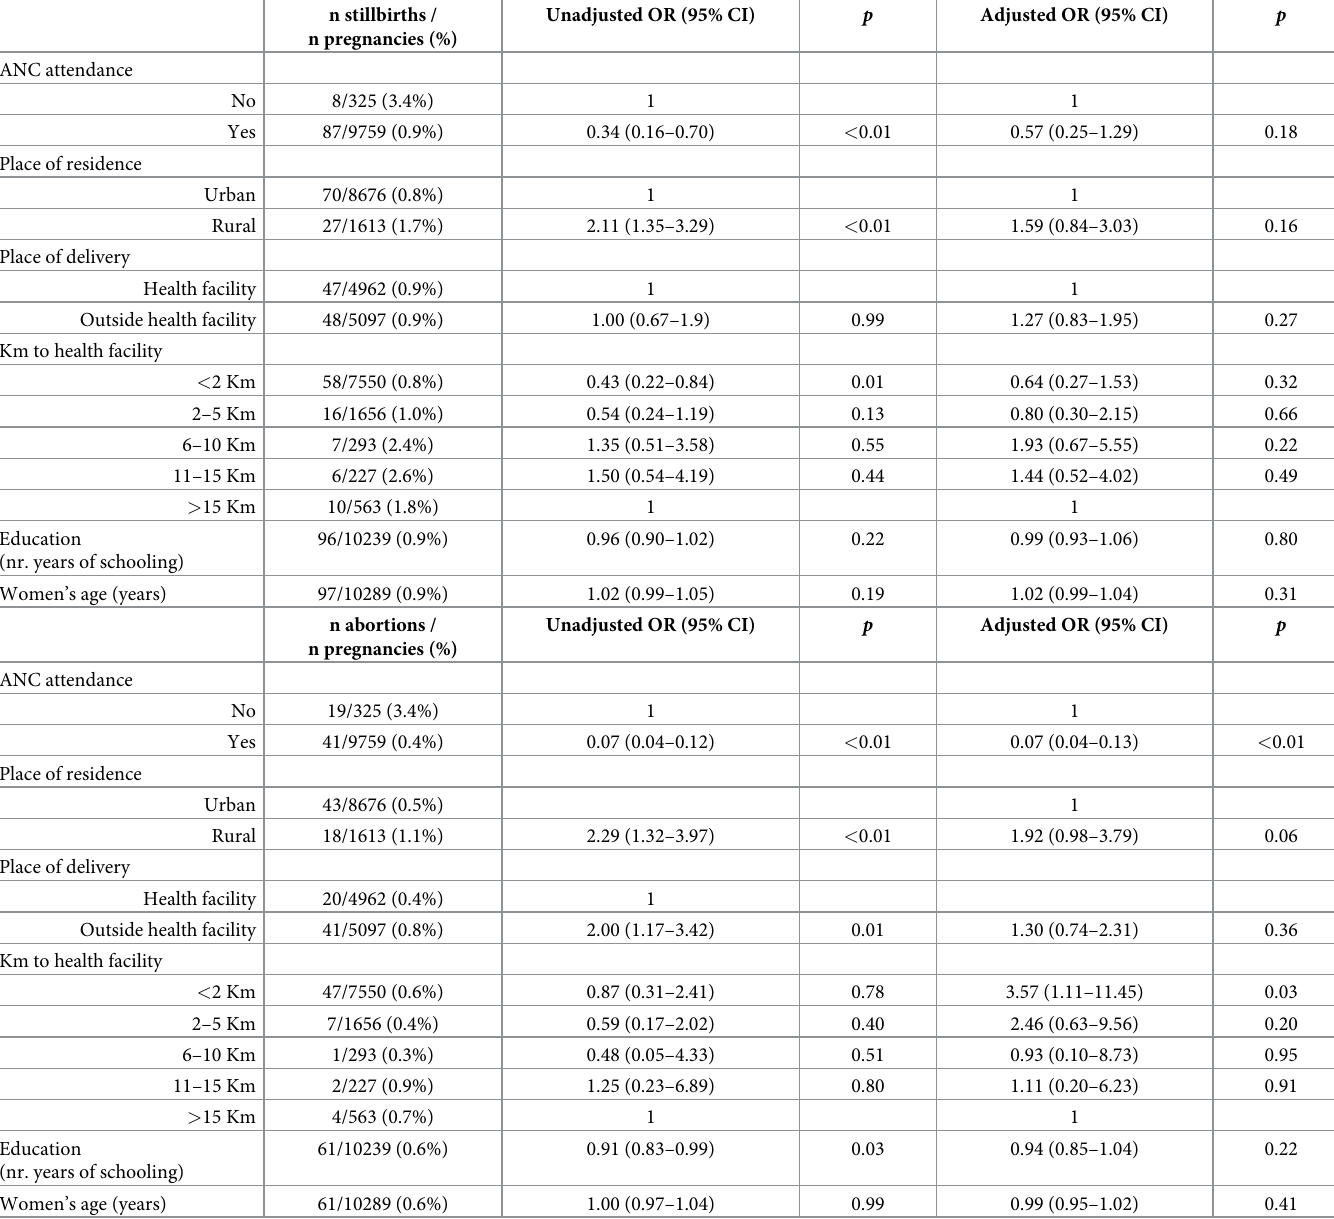
Table 2. Adjusted and unadjusted Odds Ratios (OR) of stillbirth (top table) and abortion (bottom) against predictor variables, from multinomial logistic regres- sion. Values of OR > 1 indicate increased risk of stillbirth or abortion. n stillbirths / n pregnancies